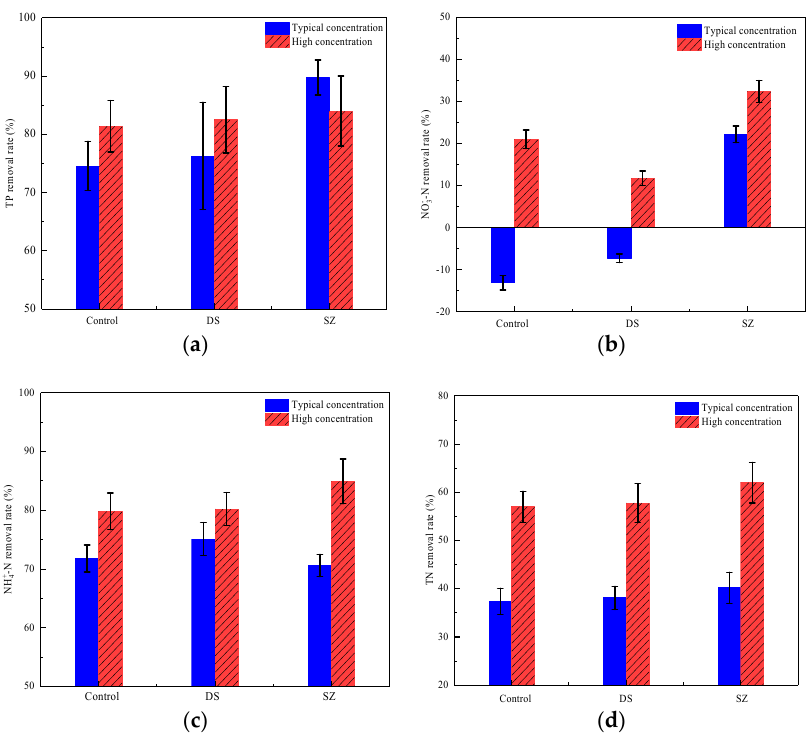
Figure 11. Removal efficiency of ( a ) TP, ( b ) NO 3 − -N, ( c ) NH 4+ -N, and ( d ) TN (total nitrogen) with different concentration in bioretention systems.